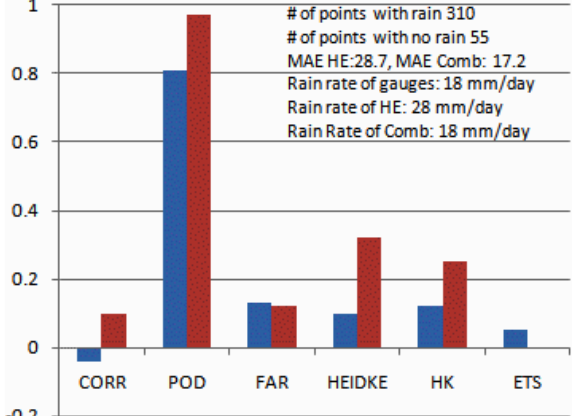
Fig. 16. Statistical evaluation of 18 June 2008 for HE (blue) and COMB